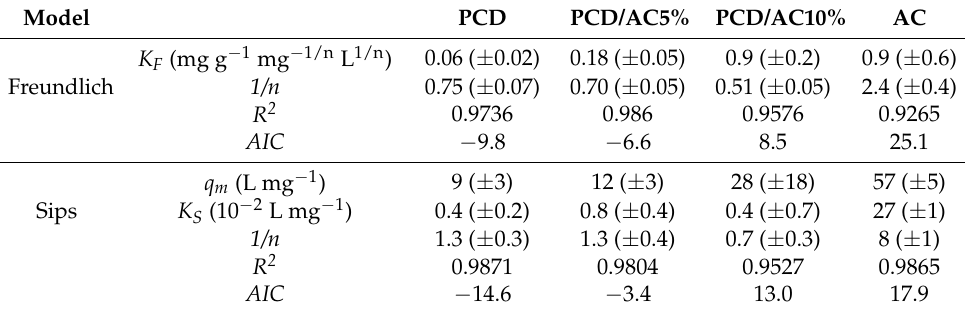
Table 6. Sorption fitting parameters for cymoxanil (see Figure 5).